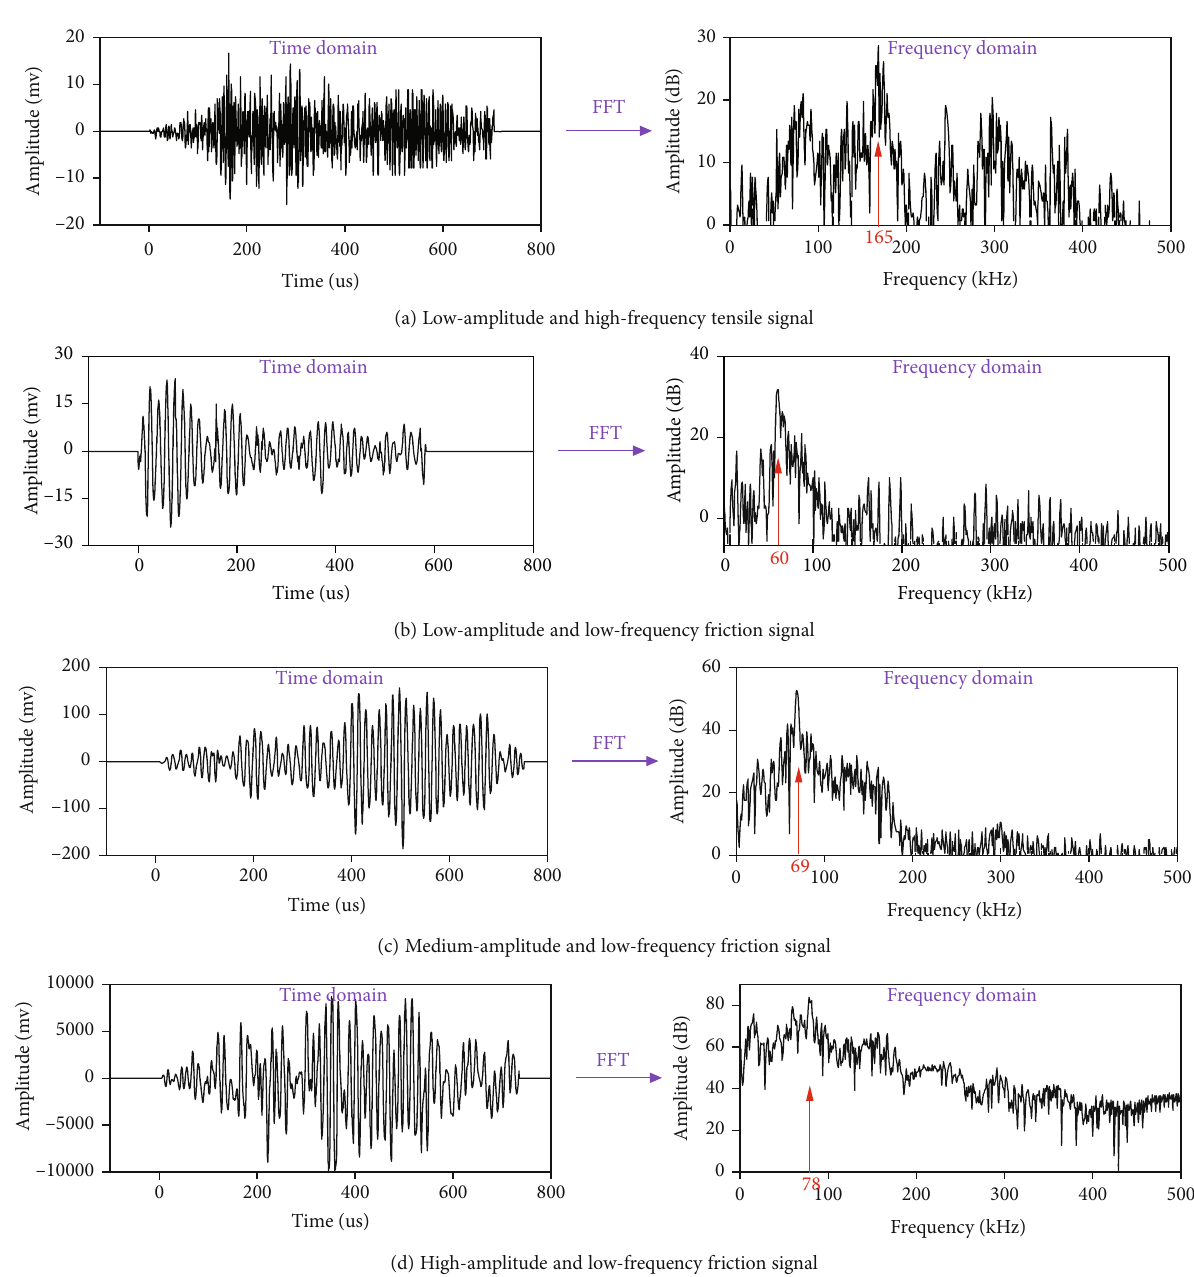
Figure 14: Typical AE waveform and spectrum signals of rock joints under direct shear